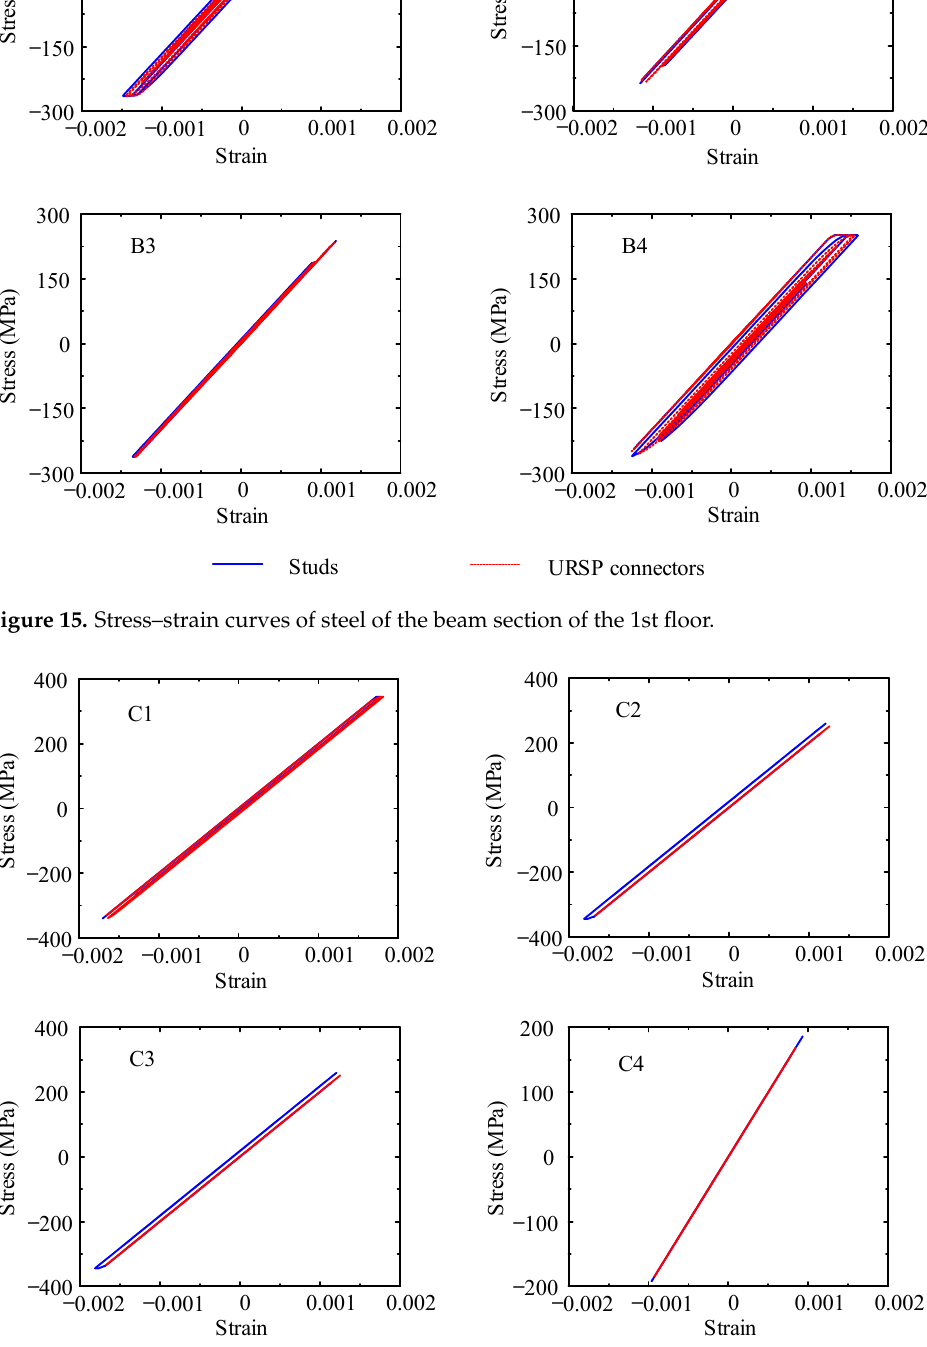
Figure 16. Stress–strain curves of steel of the bottom column.